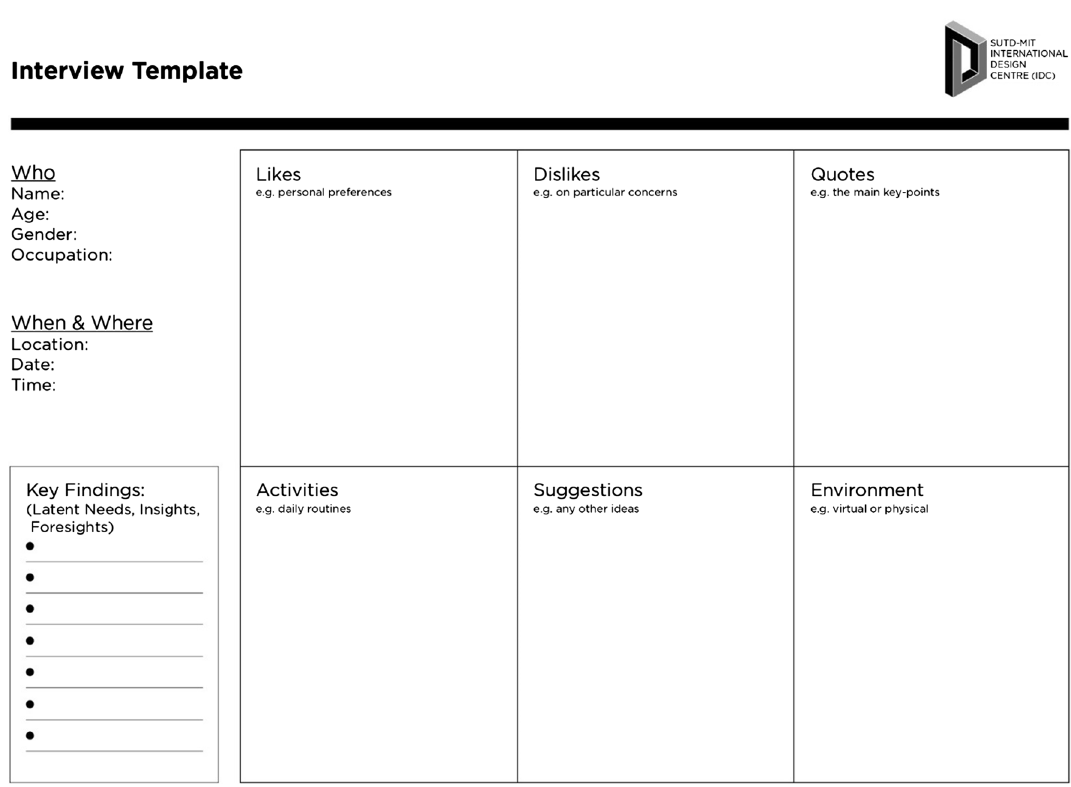
Fig. 5 SUTD-MIT interview template for Product-Service-System